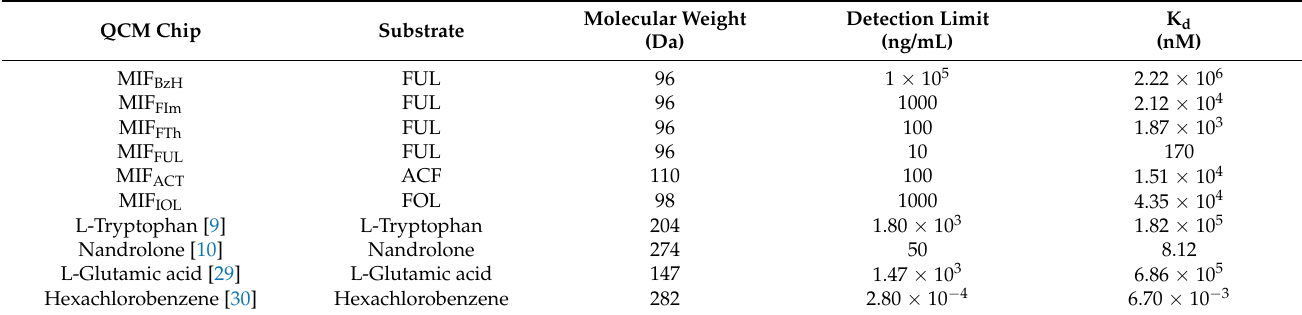
Table 2. Comparison of various MIF-QCM assays in different analytes.